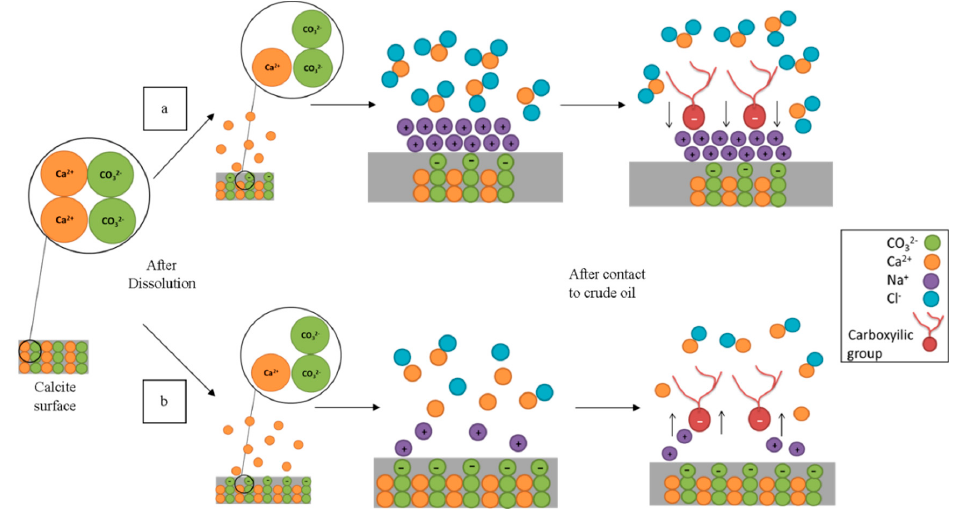
Figure 4. Schematic model of the proposed mechanism for wettability alteration by ( a ) Hsal and ( b ) Lsal brines.